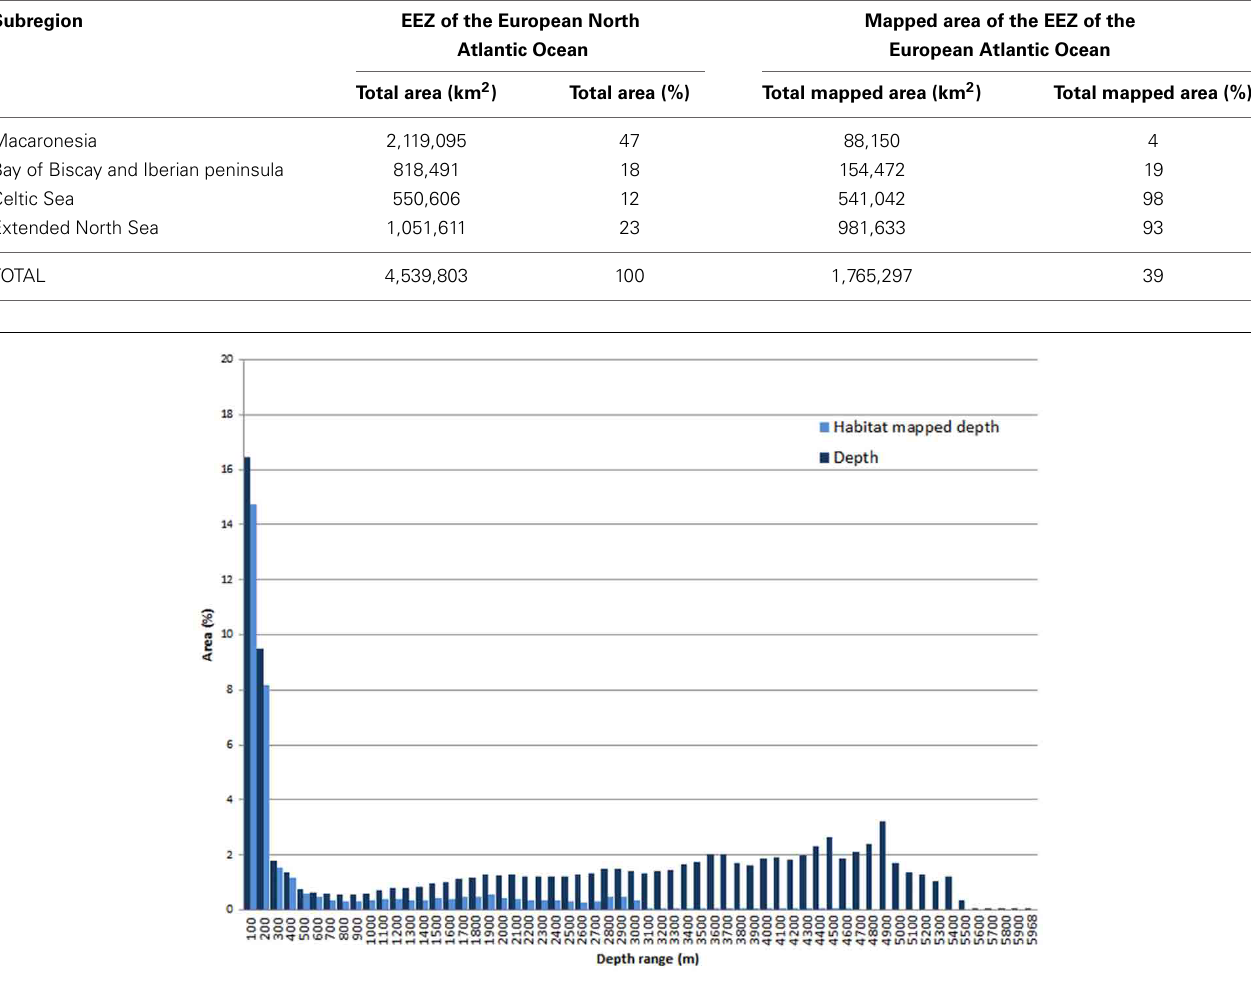
Frontiers in Marine Science | Marine Ecosystem